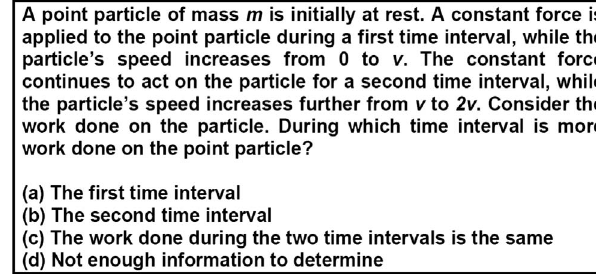
FIG. 16. One item (cid:1) Q33 (cid:2) from the MIET.